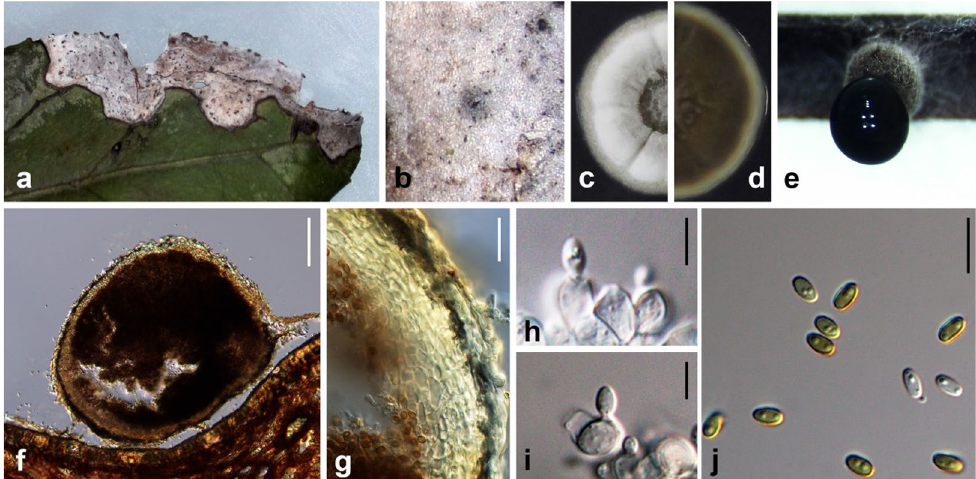
Figure 10. Paraconiothyrium camelliae (NTUH 18–096, holotype ). ( a ) Leaf lesions ( b ) Appearance of conidiomata on host surface. ( c , d ) Cultures on PDA, from above and below. ( e ) Pycnidia on pine needle. ( f ) Vertical section of conidioma. ( g ) Conidiomatal wall. ( h , i ) Conidiogenous cells and developing conidia. ( j ) Conidia. Scale bars: ( f ) = 100 μm, ( g ) = 20 μm, ( h , i ) = 5 μm, ( j ) = 10